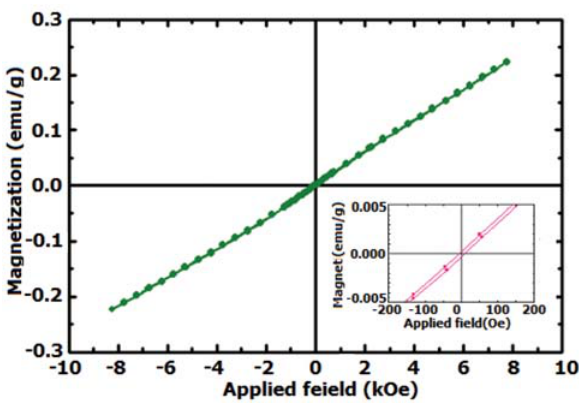
Figure 8. (a) Magnetization curve as a function of applied magne- tic field for Co